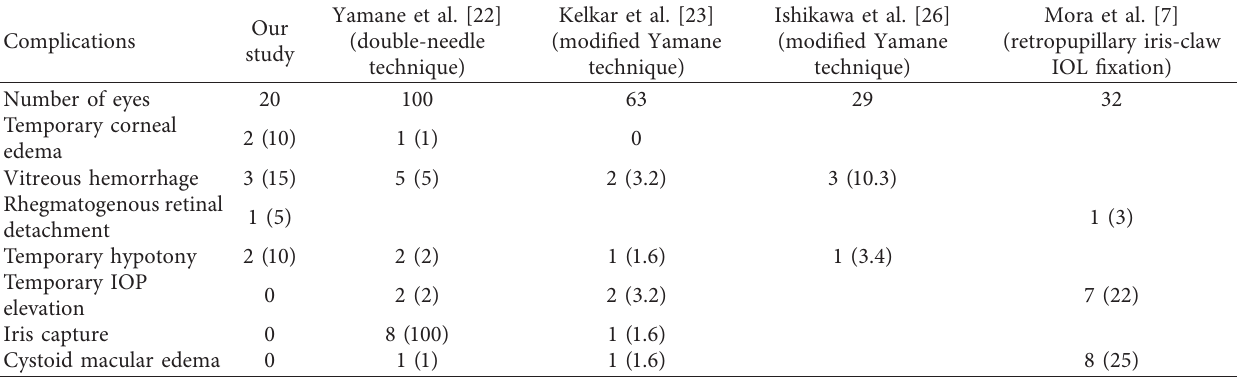
Table 3: Comparison of complications with other techniques of intrascleral and retropupillary fixation of intraocular